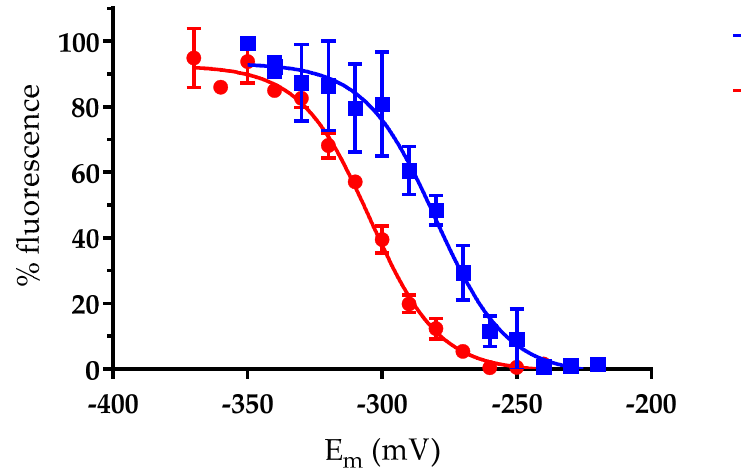
Figure 3. Redox midpoint potentials of glutathionylated and disulfide-bridged forms of At GRXS15. After incubation of pre-oxidized recombinant At GRXS15 (10 µM) forms (either glutathionylated monomer or oxidized dimer) in mixtures of DTT red /DTT ox with defined redox potentials, reduced thiols were labelled with mBBr. Fluorescence emission corresponding to mBBr-labelled thiols was then transformed to a % fluorescence (relatively to the minimum and maximum values obtained), which was plotted against the respective redox potentials. Data are represented as mean ± SD of three independent experiments.